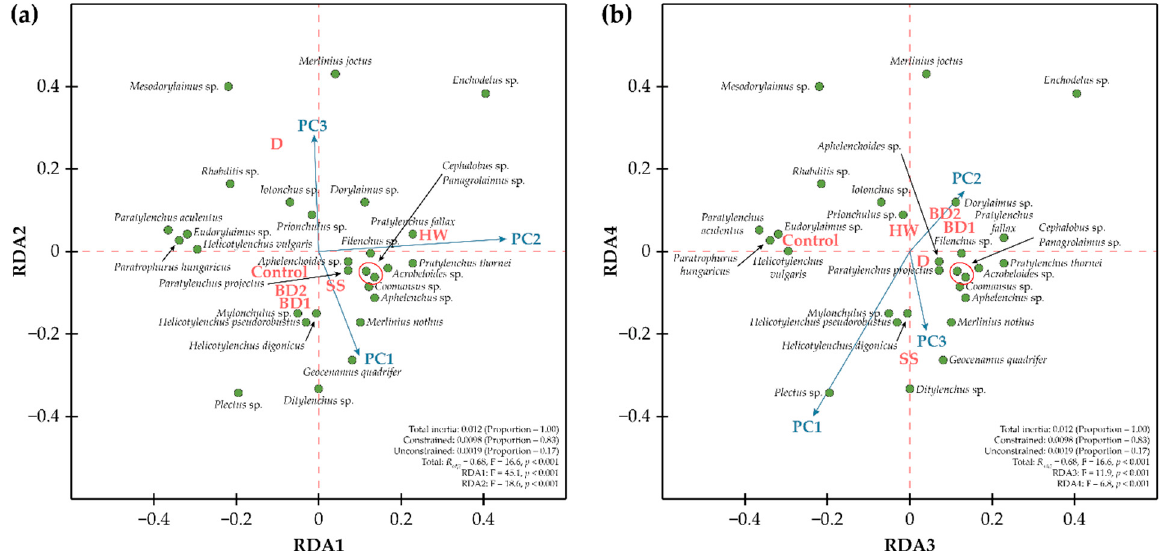
Figure 1. Partial RDA of the nematode community with biological stimulators as constrained variables (red colour) and fitting of the synecological PC into the RDA axes (blue arrows). Green points indicate species positions. ( a ) RDA1-RDA2; ( b ) RDA3-RDA4.